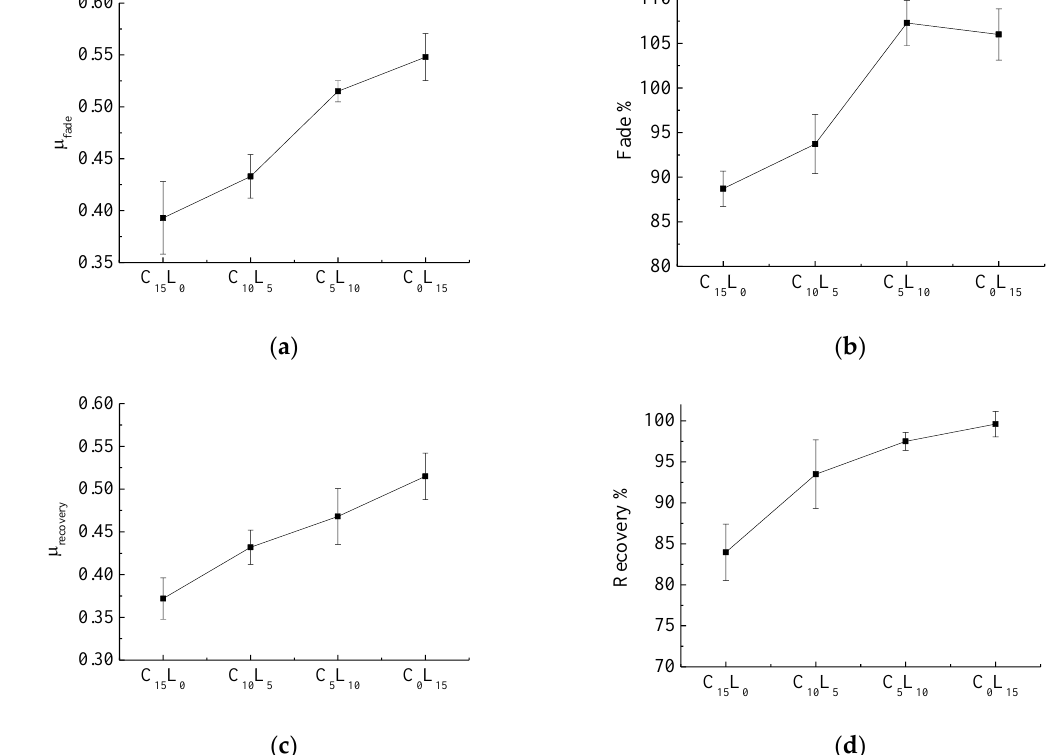
Figure 4. Fade and recovery behaviors of the brake composites: ( a ) µ fade ; ( b ) fade%; ( c ) µ recovery ; ( d ) recovery%.